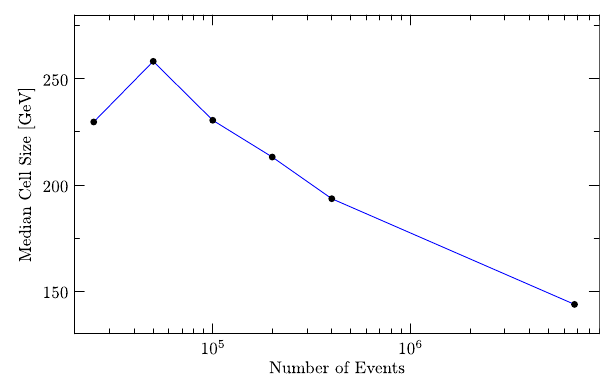
Fig. 2 Median cell radius as a function of sample size according to the distance measure defined in Sect. 2.1.1 with τ = 0. See Sect. 3 for details on the event